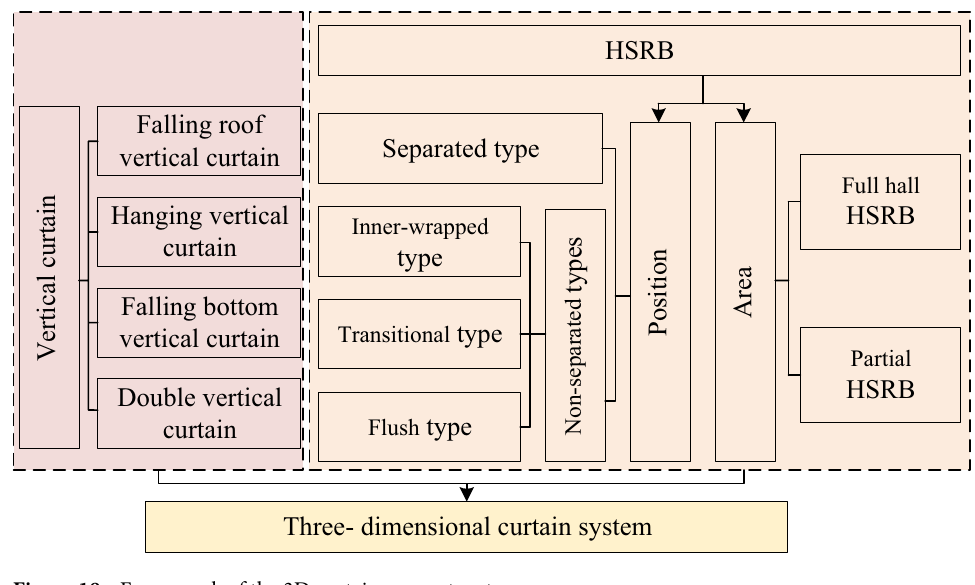
Figure 18. Framework of the 3D curtain concept